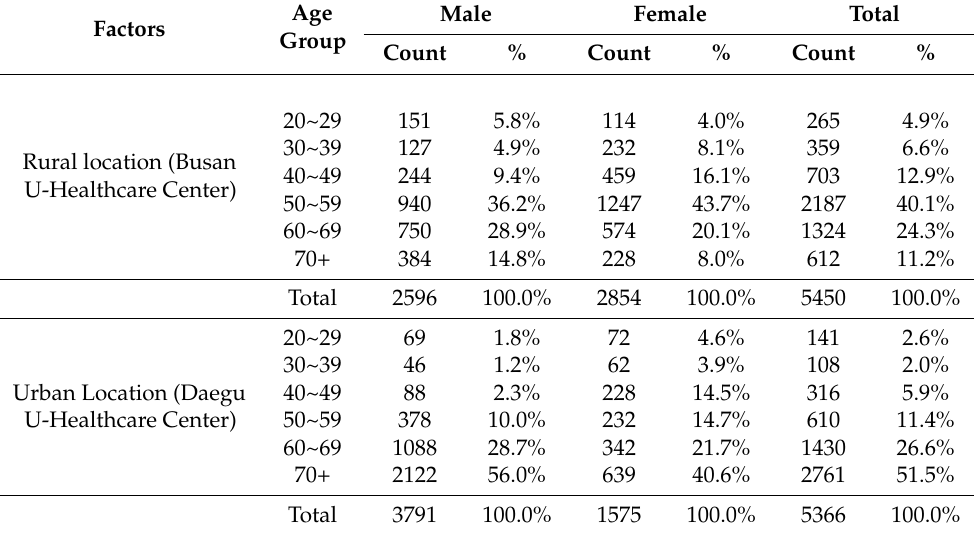
Table 1. Demographic characteristics of users at U-Healthcare centers.